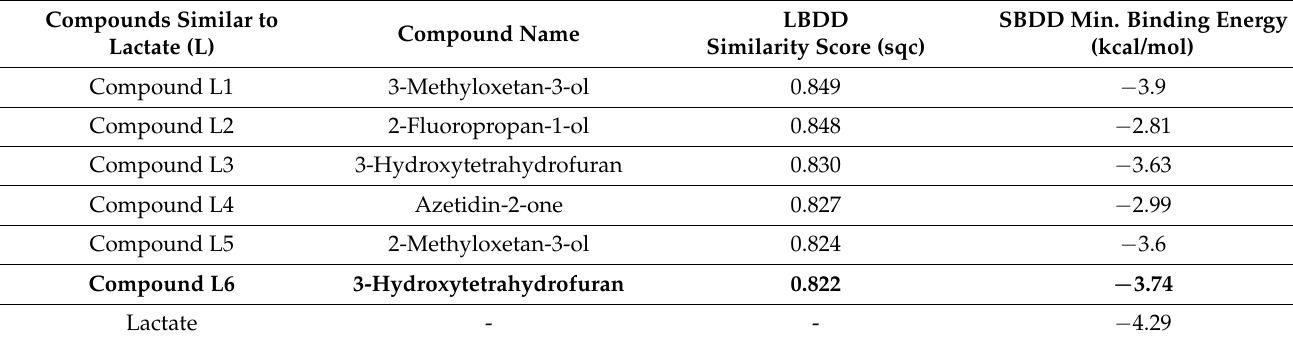
Table 2. Similarity scores from ligand-based drug design, and minimum binding energies from structure-based drug design for compounds that were structurally similar to lactate (L). The row in bold indicates the compound that was selected for inhibition analysis.